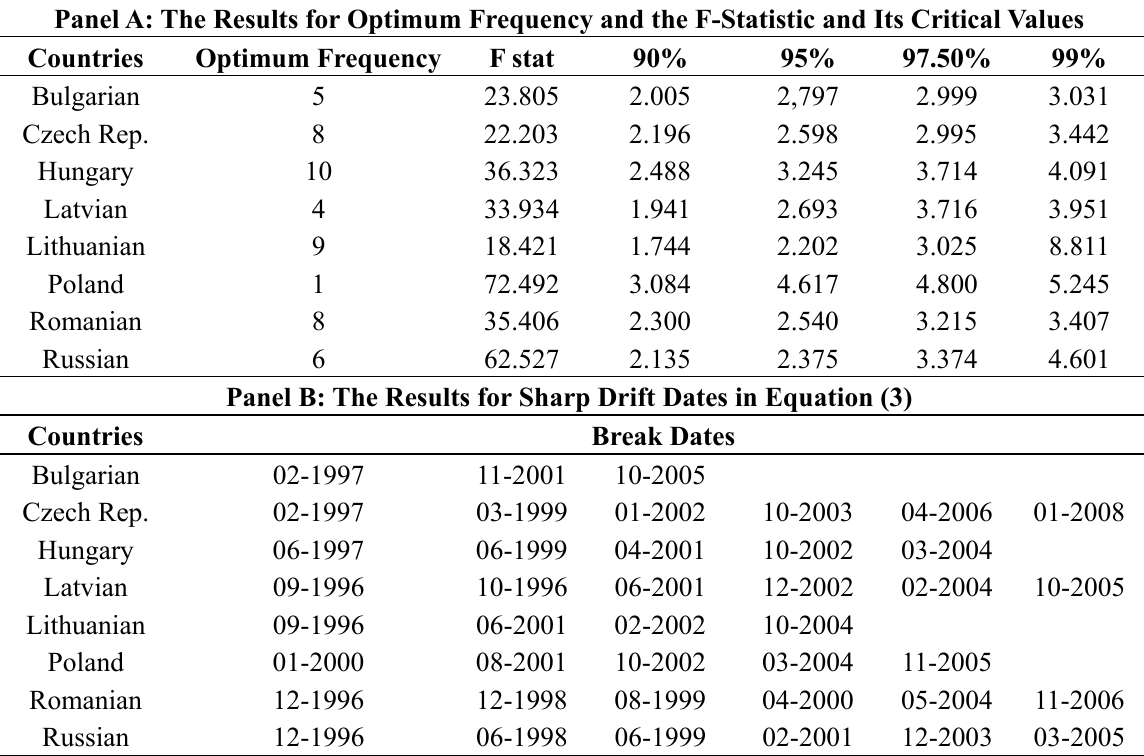
Table 3. Estimation results for the mean reverting function in Equation (3). Panel A: The Results for Optimum Frequency and the F-Statistic and Its Critical Values